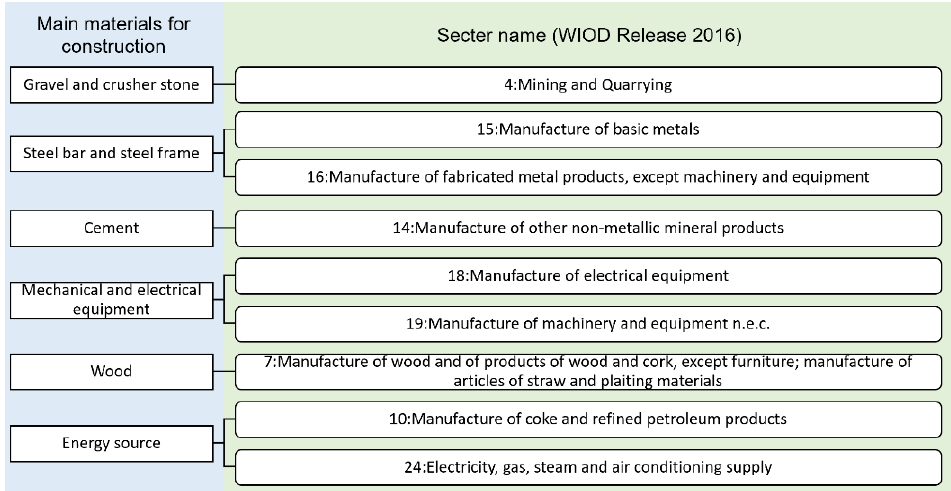
Figure 6. Sector-specific construction materials.